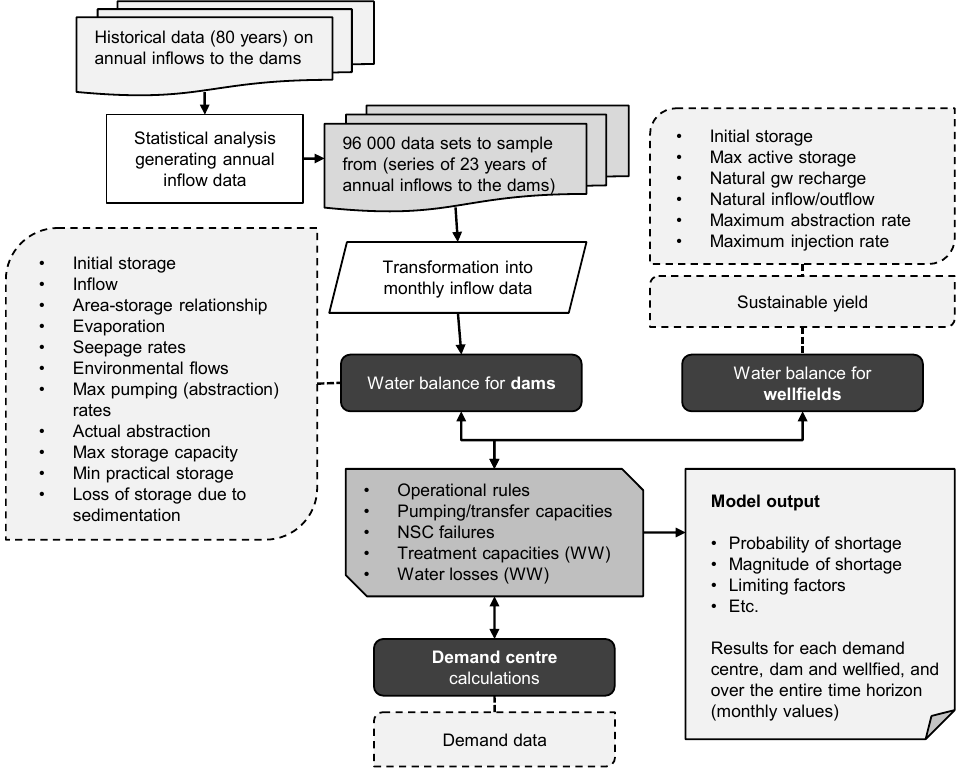
Figure 2. Overview of the parameters considered in the model and the link between them.